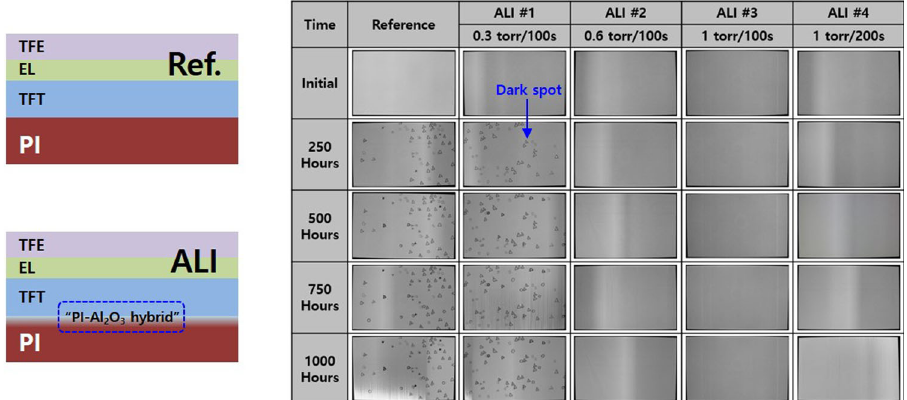
Fig. 4 The results of storage test. Lighting test results for the reliability of the fabricated fl exible OLED displays according to ALI process conditions and storage time in a chamber with high temperature (85 °C) and high humid (85%